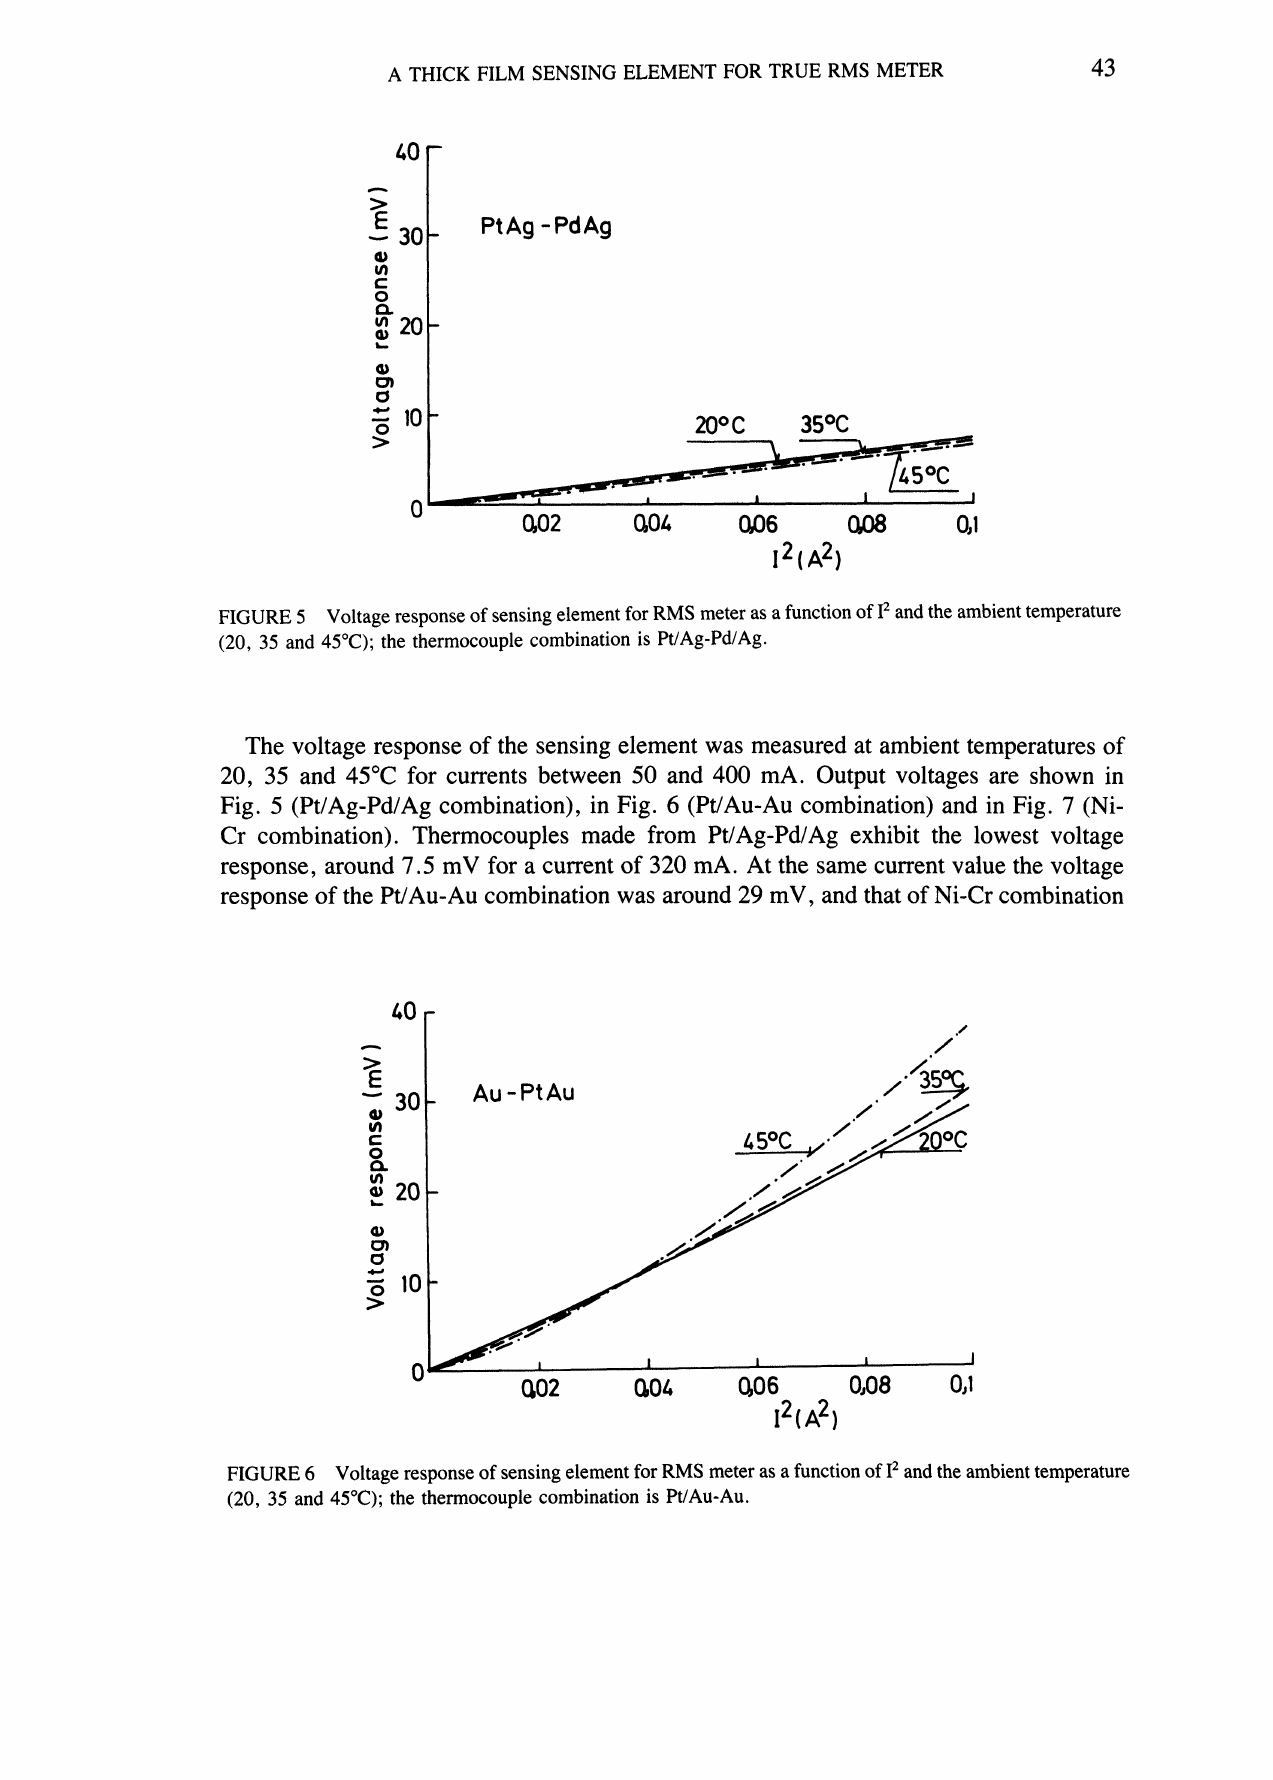
FIGURE 6 Voltage response of sensing element for RMS meter as a function of 12 and the ambient temperature (20, 35 and 45C); the thermocouple combination is